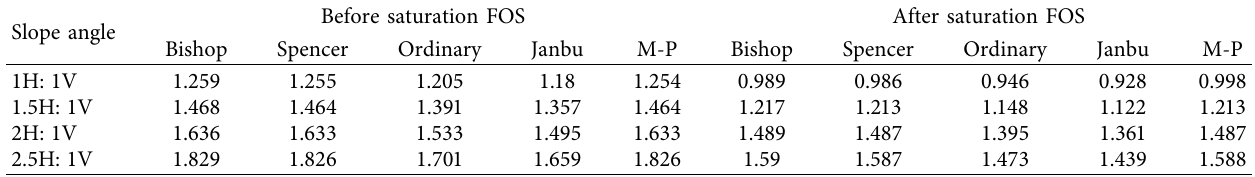
Table 11: FOS values for slope-4 for different slope angles before and after saturation.